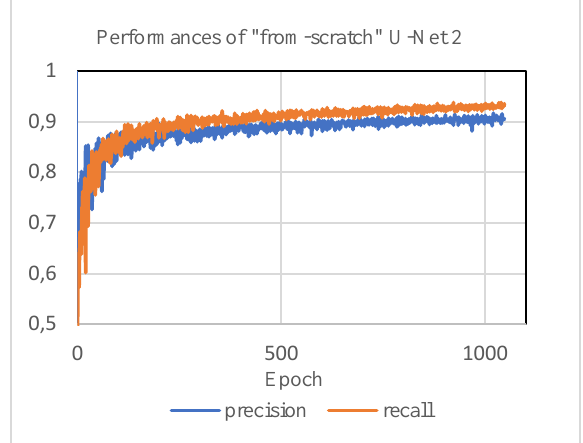
Figure 3. Performances of U-Net 2 (2 million parameters) when learning is done from